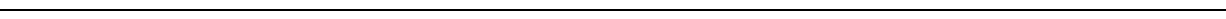
Fig. 4 il-6 does not rescue the shortened regeneration length of il-11 KD tadpoles. a – f Representative images of tails of control cas9 mRNA-injected a , b , il-11 knockeddown acgfp -expressing c , d , or il-11 knockeddown il-6 – expressing e , f tadpoles, and their regeneration length g are shown. Dark- fi eld images a , c , e and GFP2- fi ltered images b , d , f are shown. Regeneration length was normalised by snout to vent length (SVL). h , i , SVL h and regeneration length i used for calculation in g are shown. j Biological replicates using different batches of tadpoles are shown. Box plots are inserted in the panels. Bars in the boxes represent median, upper and lower limits of the boxes represent the fi rst and third quartiles, and whiskers represent maximum and minimum values. Scale bars : 1 mm. Anterior is to the left , dorsal is up . Yellow broken lines indicate outline of the tails. White broken lines indicate amputated plane. * P < 0.05, Tukey − Kramer ’ s